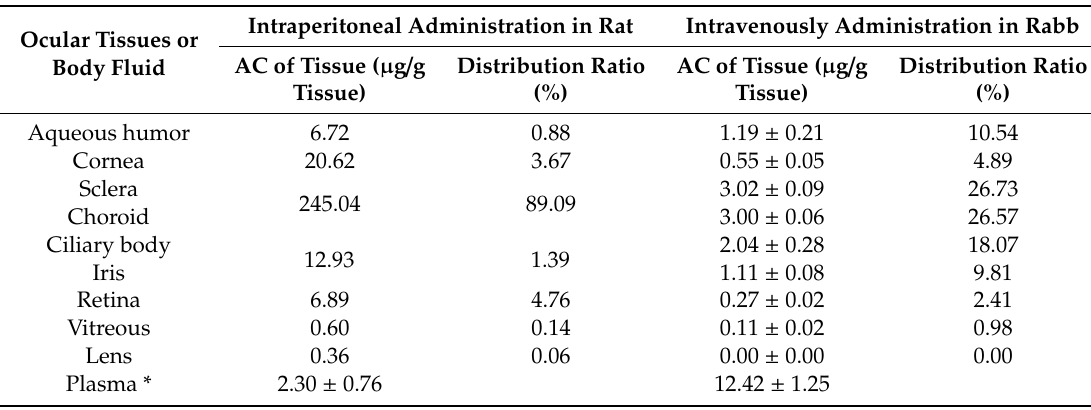
Table 1. The ocular tissue distribution of AC at 1 h post-intraperitoneal administration in rats and at